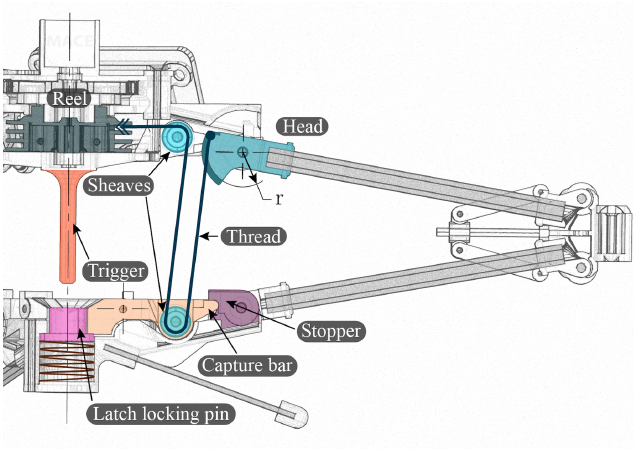
Figure 7. Compression mechanism and release latching mechanism